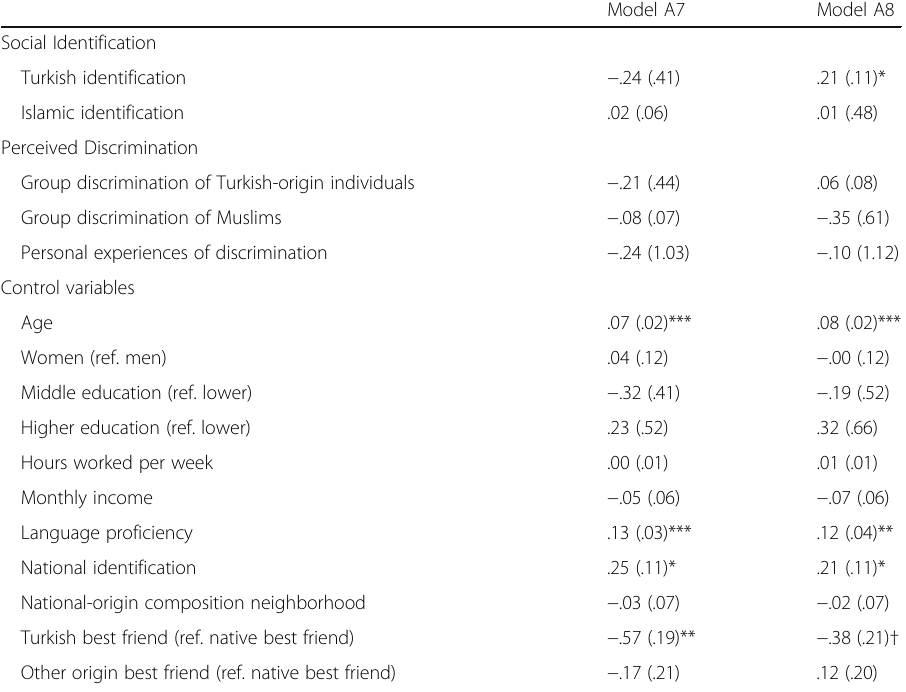
Table 12 Binary logistic regression: Interplay between social identifications, group discrimination, personal discrimination and local voting